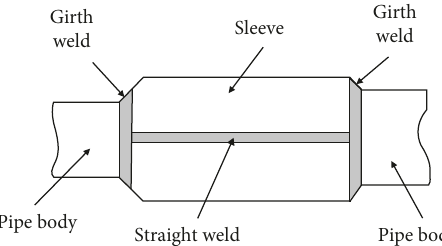
Figure 10: Schematic diagram of B -type sleeve repair.